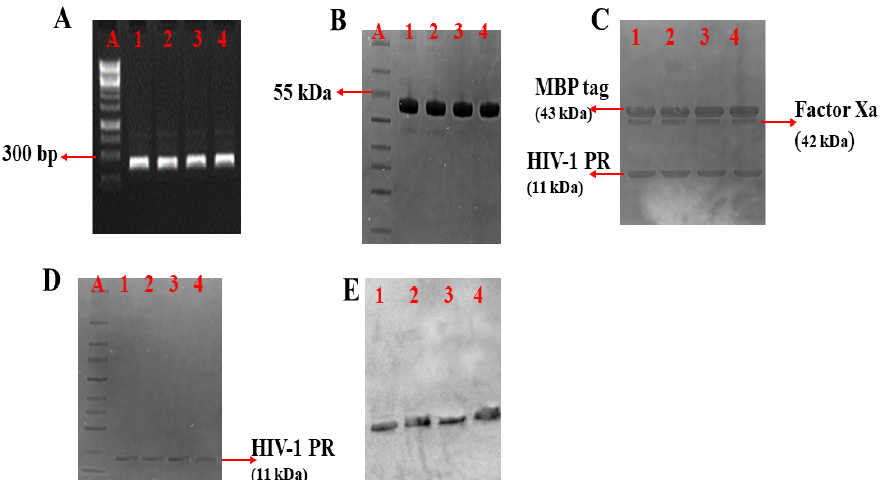
Figure 2. PCR amplification, expression, and purification of HIV-1 PR. ( A ) Amplified HIV-1 PR gene; DNA marker (Lane A), amplified HIV-1 PR wild type (WT) (Lane 1), amplified mutant HIV-1 PR variants (Lane 2 = MUT-1, Lane 3 = MUT-2, and Lane 4 = MUT-3). ( B ) SDS-PAGE showing purified MBP tagged HIV-1 PR variants: Lane A (protein marker), Lane 1 (WT), Lane 2 (MUT-1), Lane 3 (MUT-2), and Lane 4 (MUT-3). ( C ) SDS-PAGE showing cleavage products after Factor Xa cleavage of HIV-1 PR from the MBP tag: Lane 1 (WT), Lane 2 (MUT-1), Lane 3 (MUT-2), and Lane 4 (MUT-3). ( D ) SDS-PAGE showing purified HIV-1 PR variants: Lane A (protein marker), Lane 1 (WT), Lane 2 (MUT-1), Lane 3 (MUT-2), and Lane 4 (MUT-3). ( E ) Western blot picture for the HIV-1 PR variants, Lane 1 (WT), Lane 2 (MUT-1), Lane 3 (MUT-2), and Lane 4 (MUT-3).